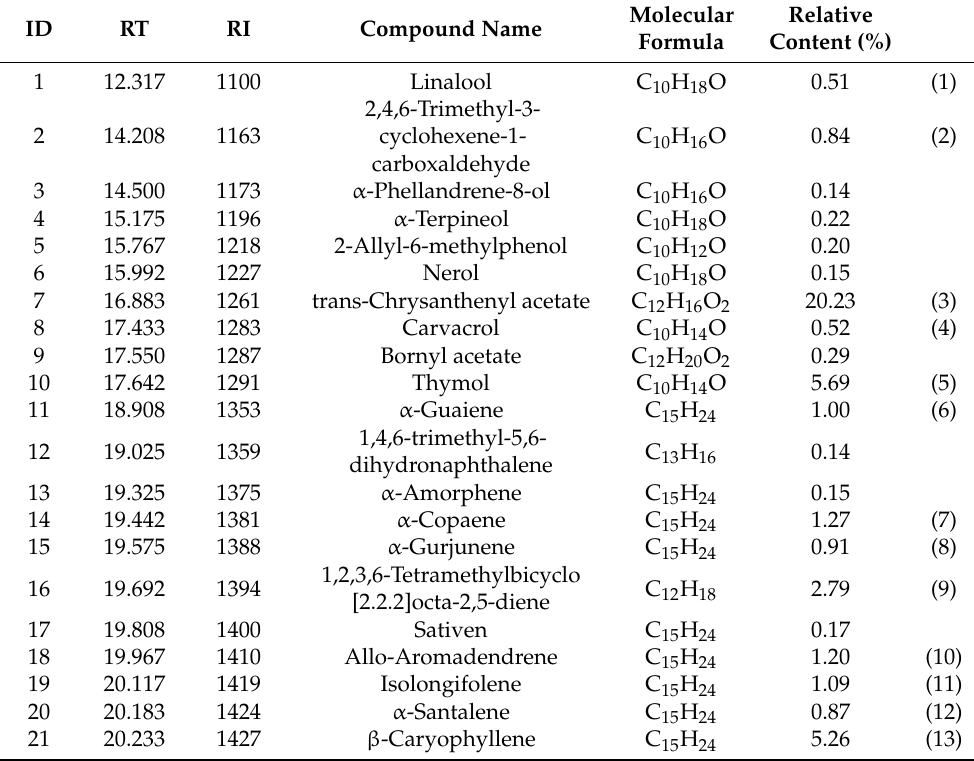
Table 1. The chemical component analysis of